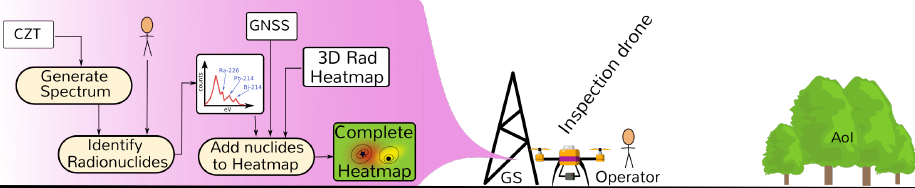
Figure 7. Inspection phase—post-flight processing: from CZT samples to radionuclide